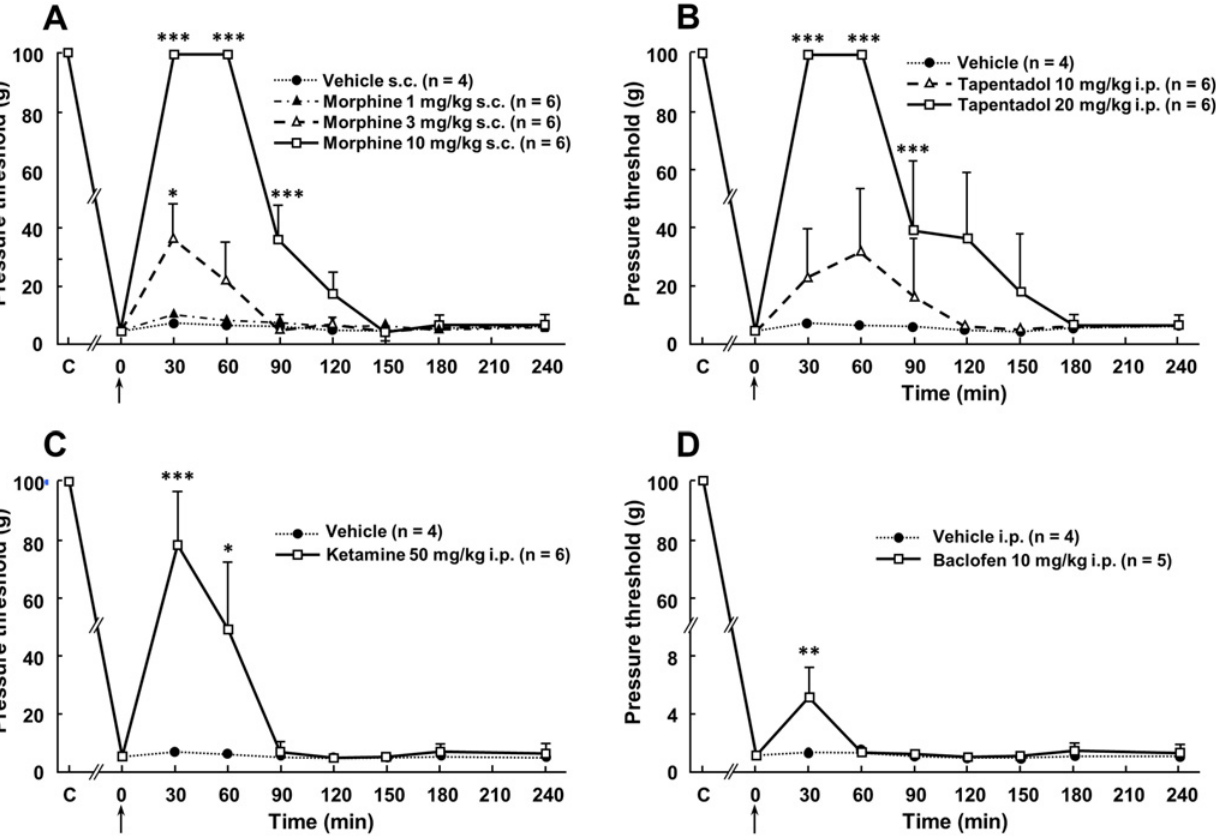
Fig 5. Anti-allodynic effects of acute administration of morphine (A), tapentadol (B), ketamine (C) or baclofen (D) in spinal cord-transected rats. Acute administration of morphine (1, 3 or 10 mg/kg s.c.), tapentadol (10 or 20 mg/kg i.p.), ketamine (50 mg/kg i.p.), baclofen (10 mg/kg i.p.) or their respective vehicle was performed (0 on abscissa, arrow) in rats whose spinal cord had been transected at T8 – T9 level one month before. Pressure threshold values to trigger nocifensive biting were determined using von Frey filaments applied within the at-level allodynic territory at various times after treatment. Each point is the mean + S.E.M. of independent determinations in n rats. C on abscissa: Control (naive) rats (prior to surgery). * P < 0.05, ** P < 0.01, *** P < 0.001 compared to respective values in vehicle-treated rats. One-way ANOVA for repeated measures followed by Dunnett ’ s test.